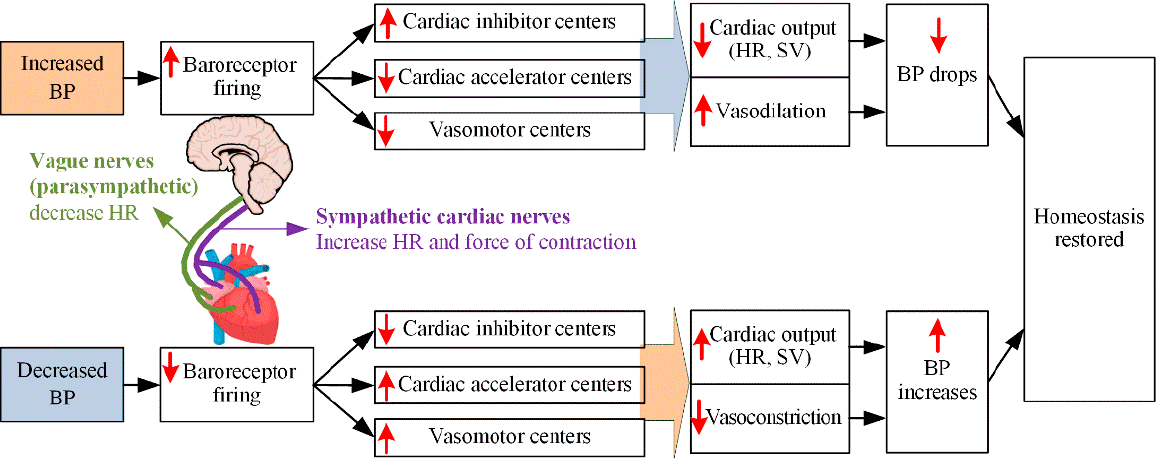
Figure 5. Relationship between BP and baroreceptor reflex ([39]).